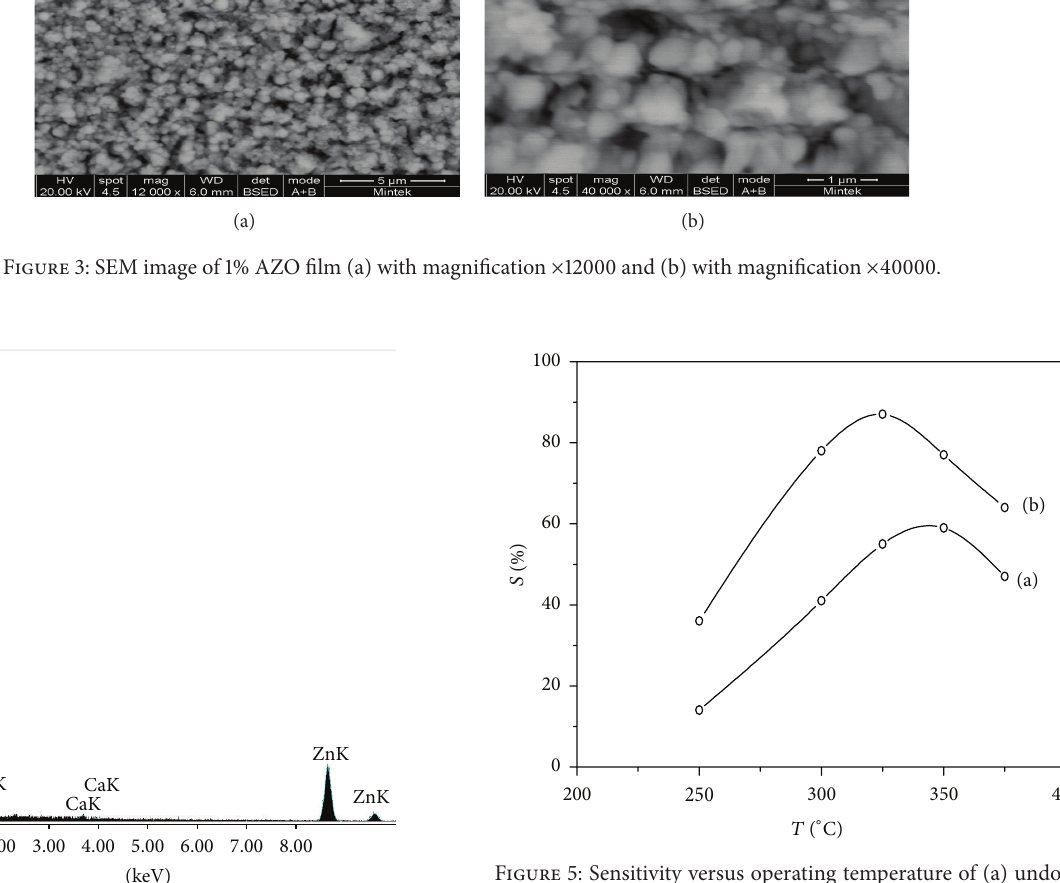
Figure 5: Sensitivity versus operating temperature of (a) undoped ZnO and (b) 1% AZO